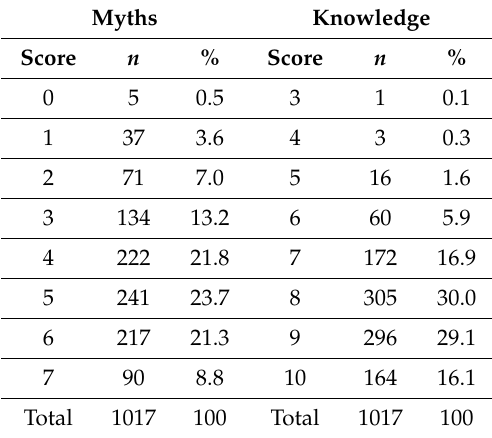
Table 1. Scores of the questionnaires applied to 1017 pregnant